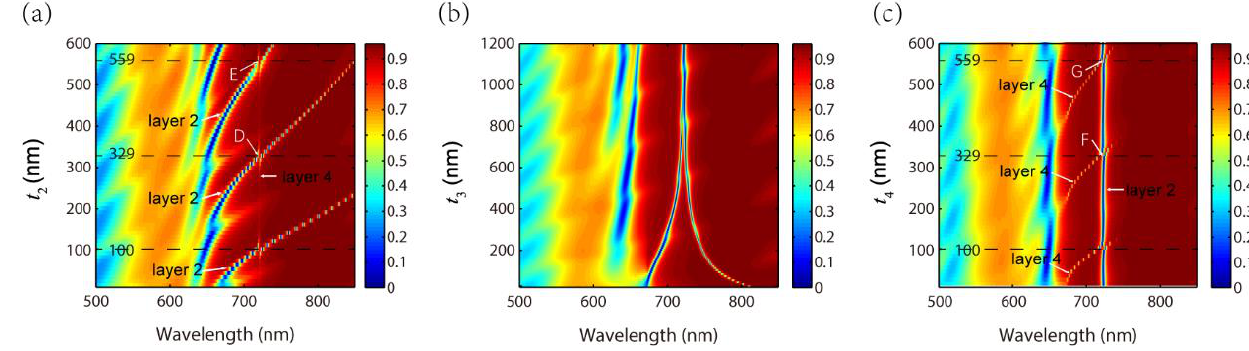
Figure 4. Reflection spectra with different ( a )